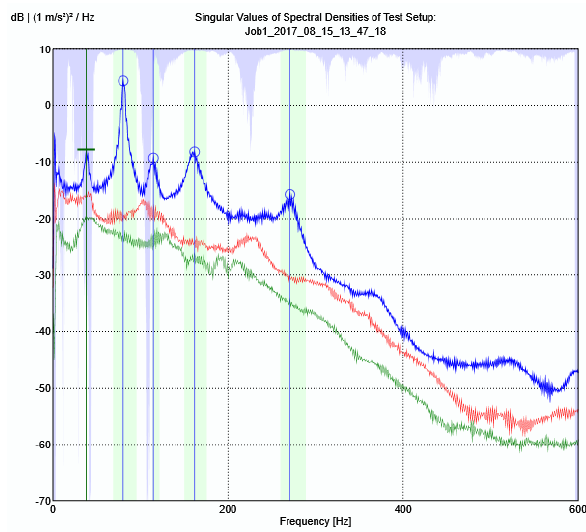
Fig. 7 Natural frequencies of the 0° laminated plates computed with ARTEMIS